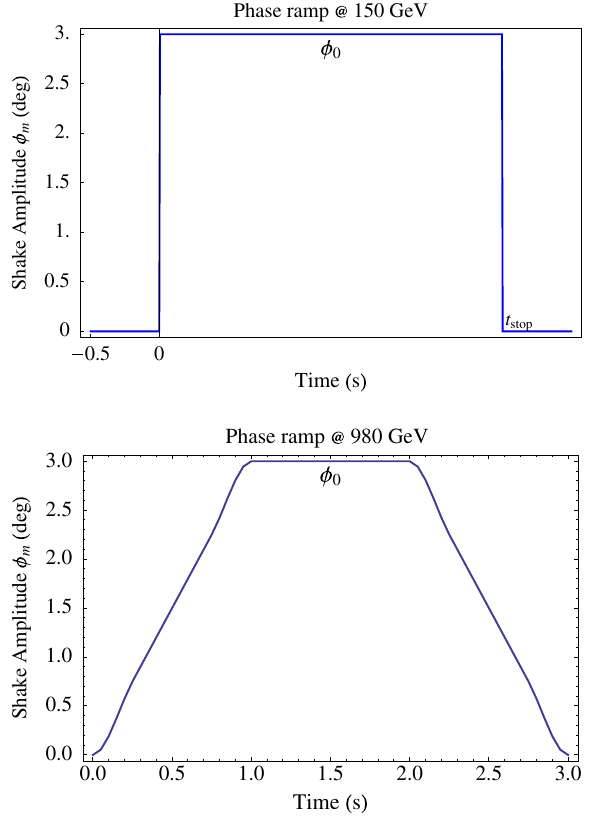
FIG. 4. These are the phase ramps (cid:2) m ð t Þ used at 150 GeV and 980 GeV. For the 150 GeV experiments, t